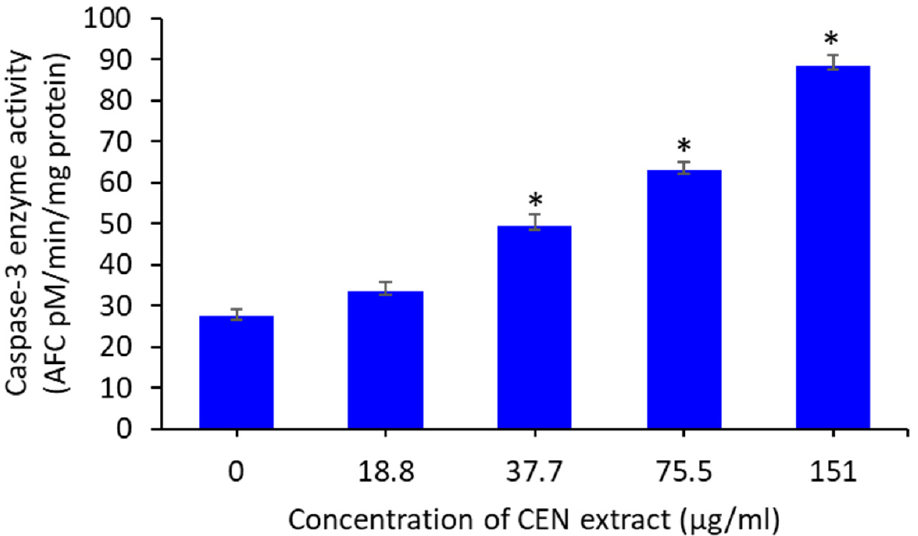
Figure 5. Caspase-3 enzyme activity of MCF-7 cells following exposure to different concentrations of ethanol extract of C. calcitrapa extract for 48 h. (*) denoted p < 0.05 relative to control. Data represent mean ± SD of 8 technical well-replicates.